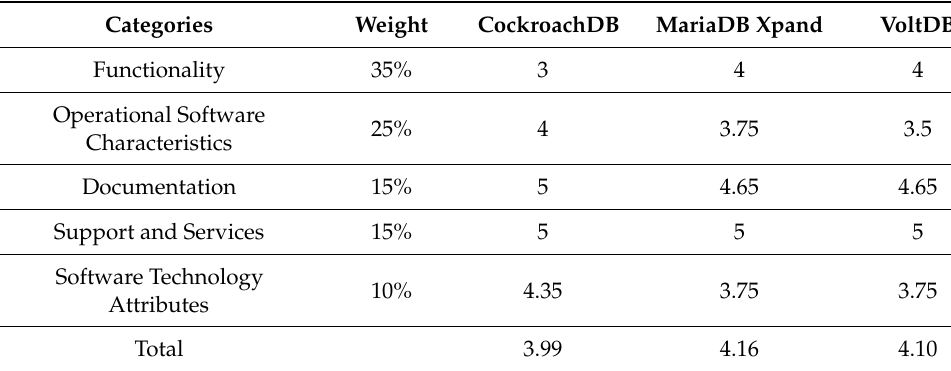
Table 4. OSSpal score by